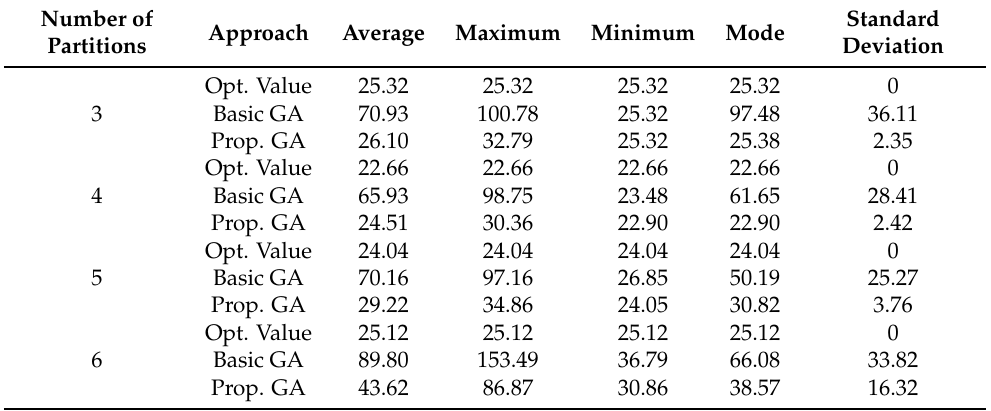
Table 4. Comparison of B-AlexNet total execution time in deploying to from three to six